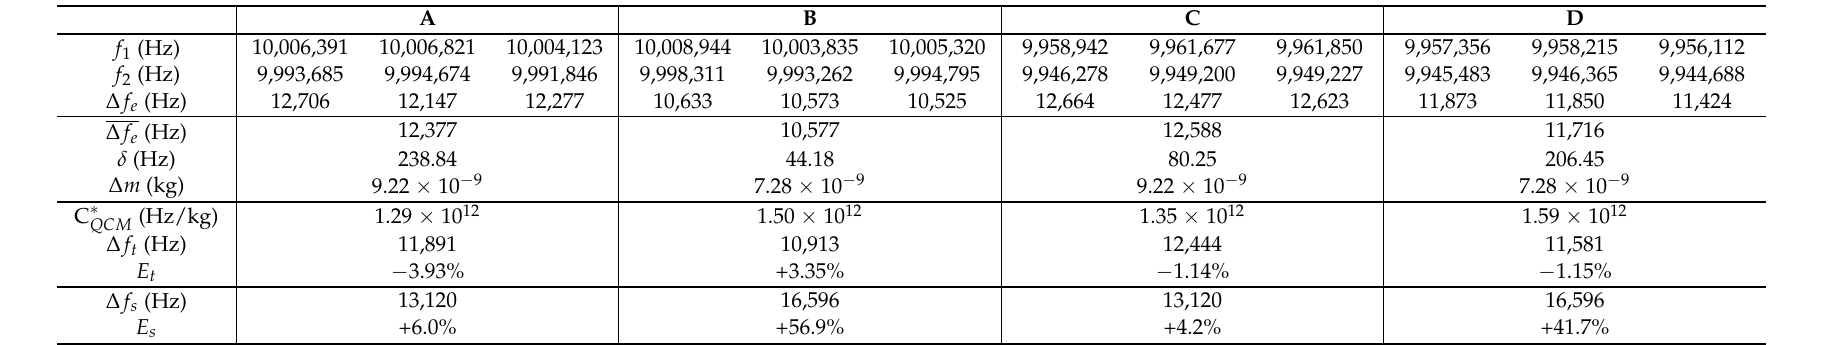
Table 1. Experimental results and theoretic